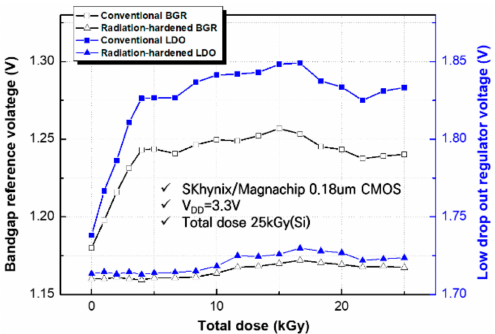
Figure 11. Change in the BGR output and LDO voltage with respect to the increasing total cumulative dose.